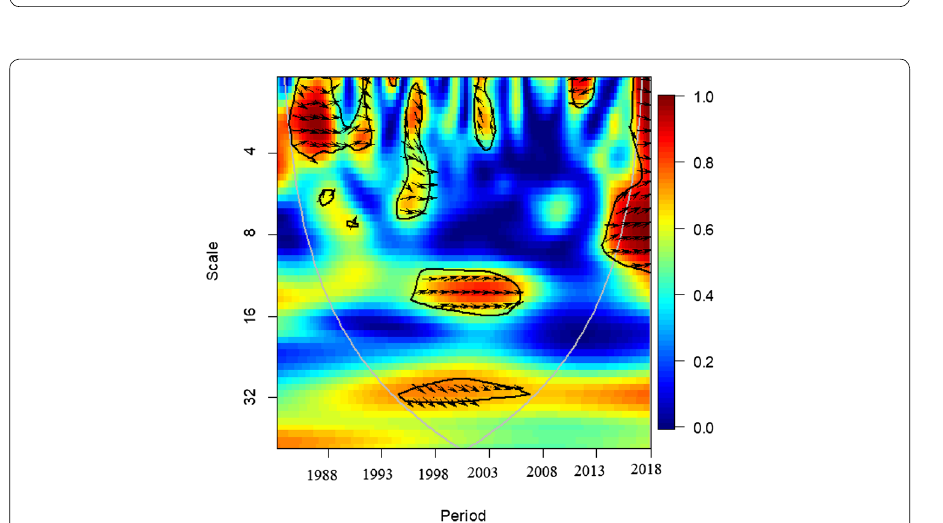
Fig. 5 Wavelet coherence between PRI and